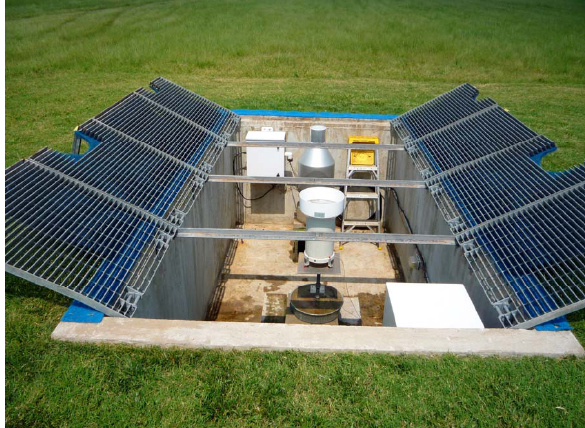
Fig. 2 View of the opened pit with the TP gauge (foreground) and WP gauge Fig. 2. View of the opened pit with the TP gauge (foreground) and (background). WP gauge (background).